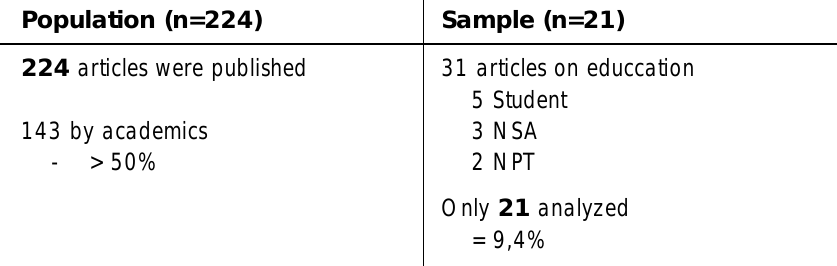
Table 1: Population and sample of participating articles.